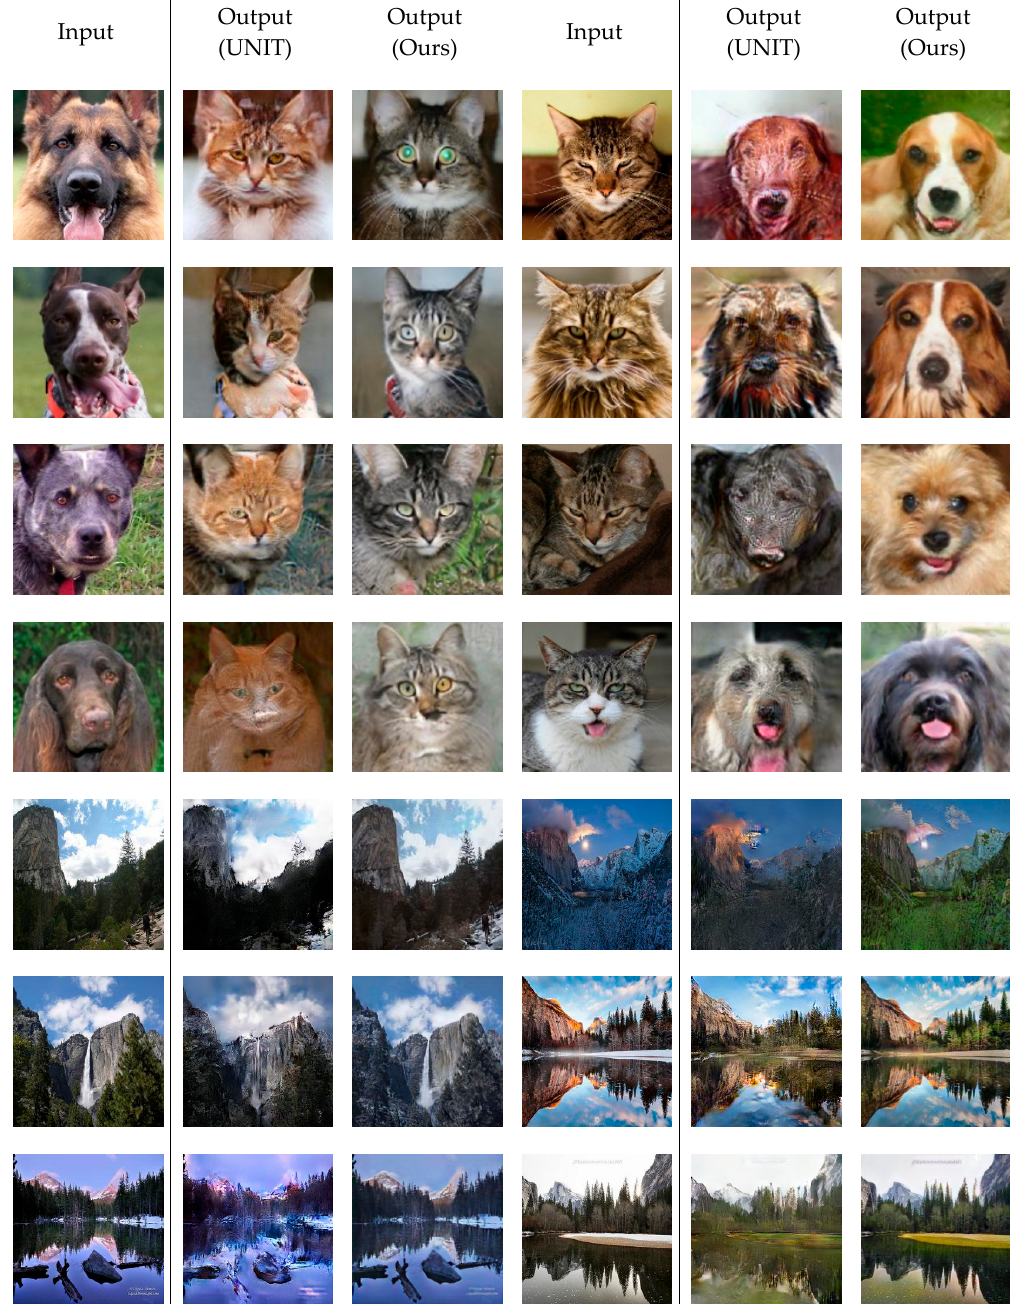
Figure A2. Comparison of the UNIT model and our model on unpaired datasets. Our results show more promising translation results on the cat2dog and summer2winter datasets compared to the baseline model (UNIT).